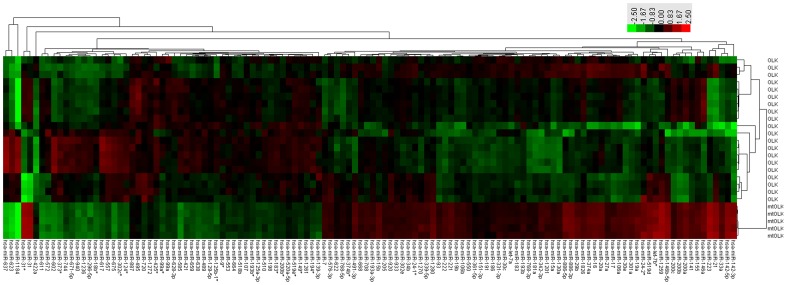
Unsupervised hierarchical cluster analysis of miRNA expression in OLK and mtOLK.The marked separation of OLK and mtOLK based on the miRNAs profiling is exhibited. Scale is shown in the upper right. Red represents a high expression and green represents a low expression. OLK, oral leukoplakia; mtOLK, malignant transformed oral leukoplakia.